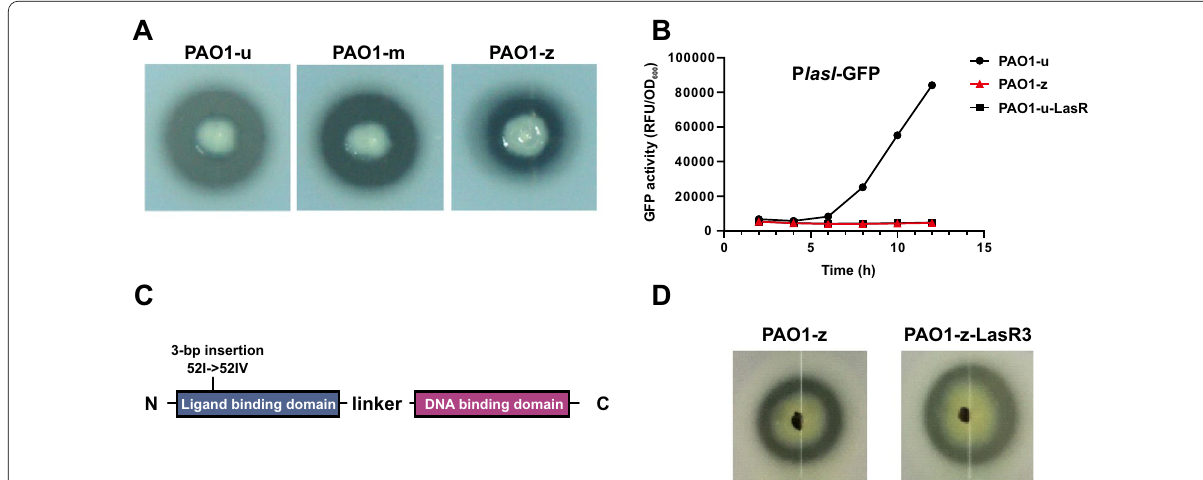
Fig. 1 QS activity profiles in P. aeruginosa laboratory strains. A Protease activity is shown in skim milk assay of three P. aeruginosa laboratory strains. An equal amount of bacteria were spotted on to the skim milk plate and photographed after 18 h of incubation. B The LasR-responsive activity in PAO1-u strain, PAO1-z strain and PAO1-u-LasR mutant. LasR-responsive activity was reflected by the fluorescence level of the P lasI -GFP reporter. The expression level of GFP in the tested strain was measured by the microplate reader and reported as relative fluorescence units (RFU). C Illustration of 3-bp insertion in the ligand-binding domain of the lasR gene in the PAO1-z strain. D Protease activity of PAO1-z strain and PAO1-z-LasR3 mutant in skim milk plate. PAO1-z-LasR3 mutant, PAO1-z strain with deleting the lasR3